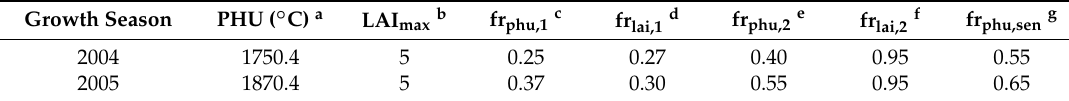
Table 6. LAI parameters of summer